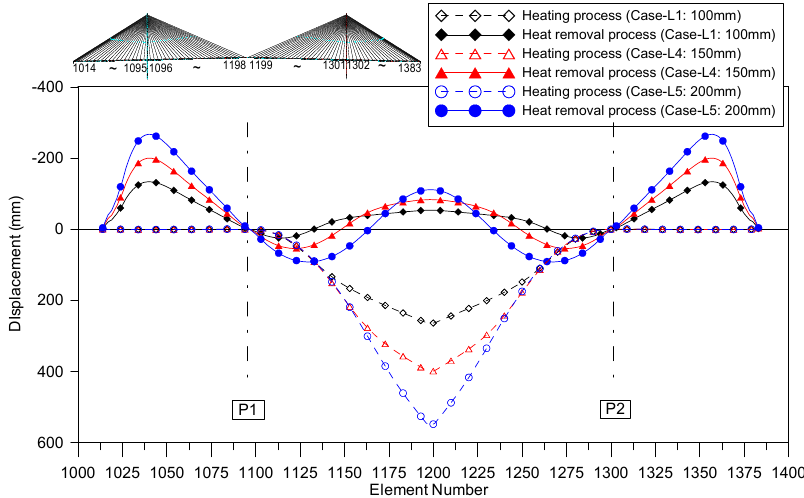
Figure 15. Girder deflections generated by heating and heat removal for various elongation lengths.